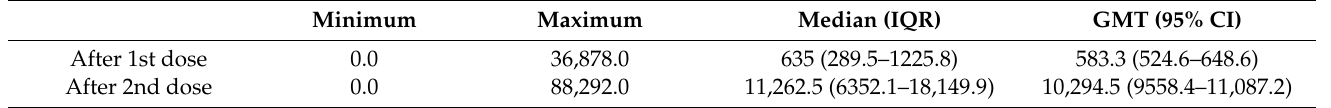
Table 2. Descriptive statistics for antibodies after the first and the second dose.